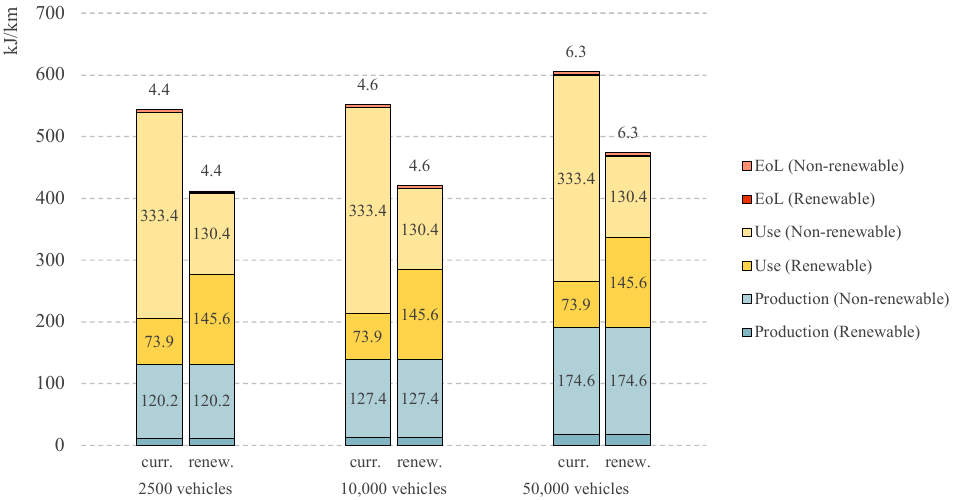
Figure 12. Lifetime cumulative energy demand of e-moped fleets per kilometer; curr.—current German electricity mix of 2019, renew.—power grid mix resembling 100% renewable